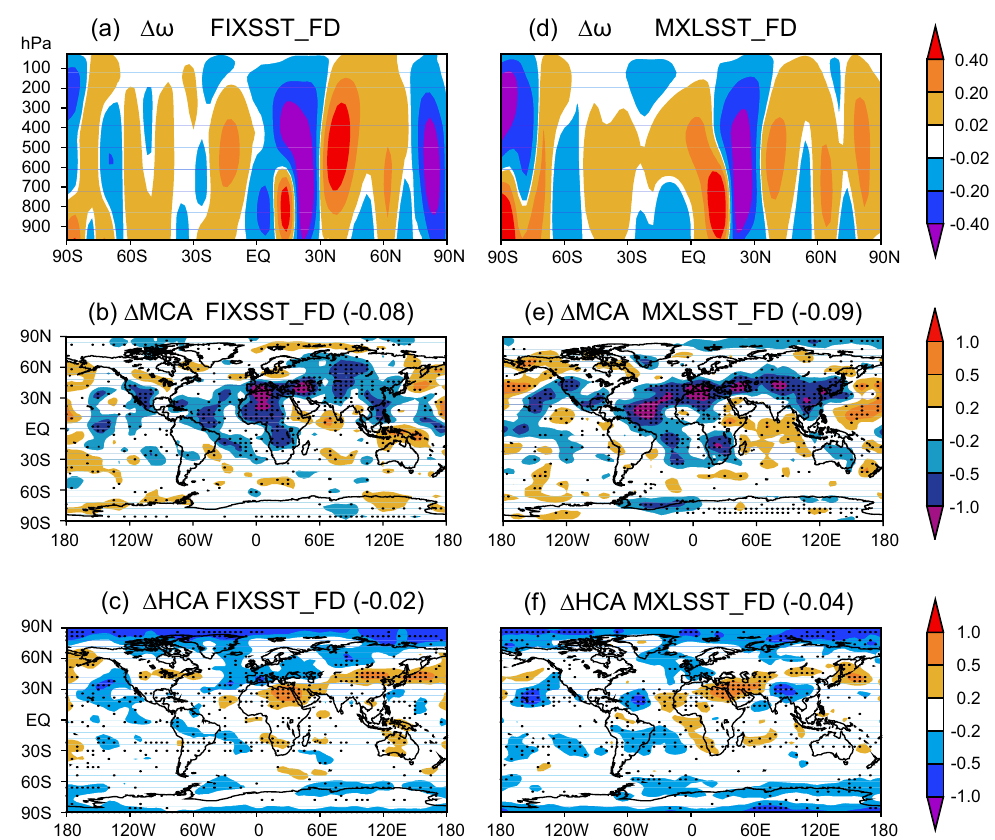
Fig. 6. Simulated dust-induced changes in annual and zonal mean vertical velocity between 60 ◦ W–60 ◦ E (hPa day − 1 , top row), annual mean middle cloud amount (%, middle row), and annual mean high cloud amount (%, bottom row). Left panels: dust-induced changes in meteorological fields with fixed dust density and fixed SST (FIXSST FD – FIXSST CTRL). Right panels: dust-induced changes with the mixed-layer ocean and fixed dust density (MXLSST FD – MXLSST CTRL).